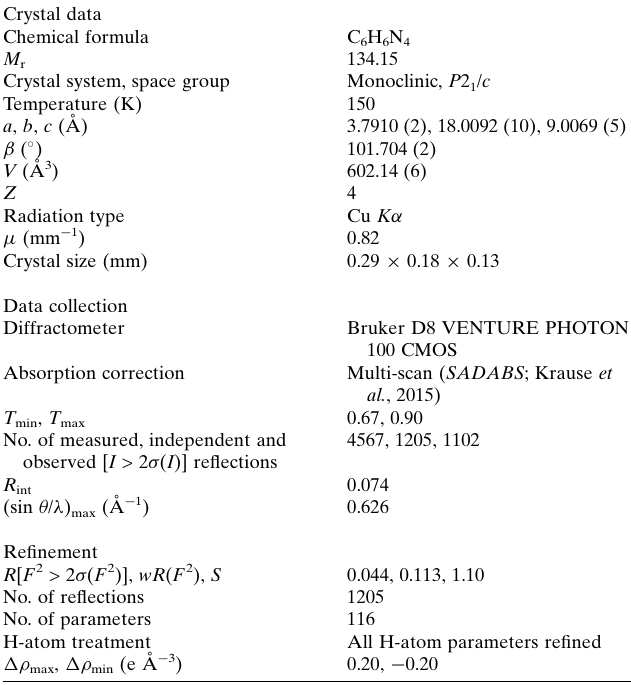
Table 3 Experimental details. Crystal data Chemical